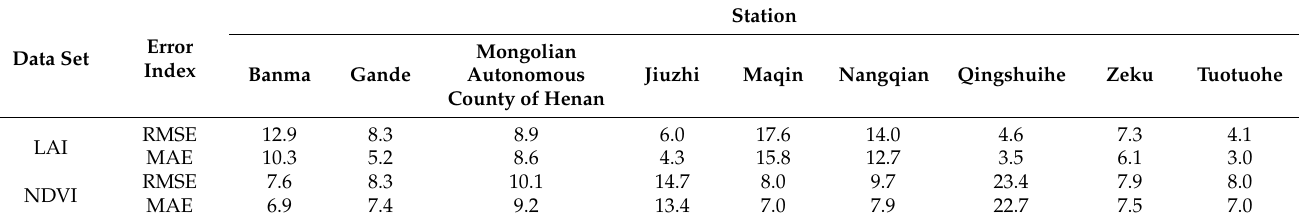
Table 2. Error comparison of the SOS data of the vegetation in the Three-River headwaters